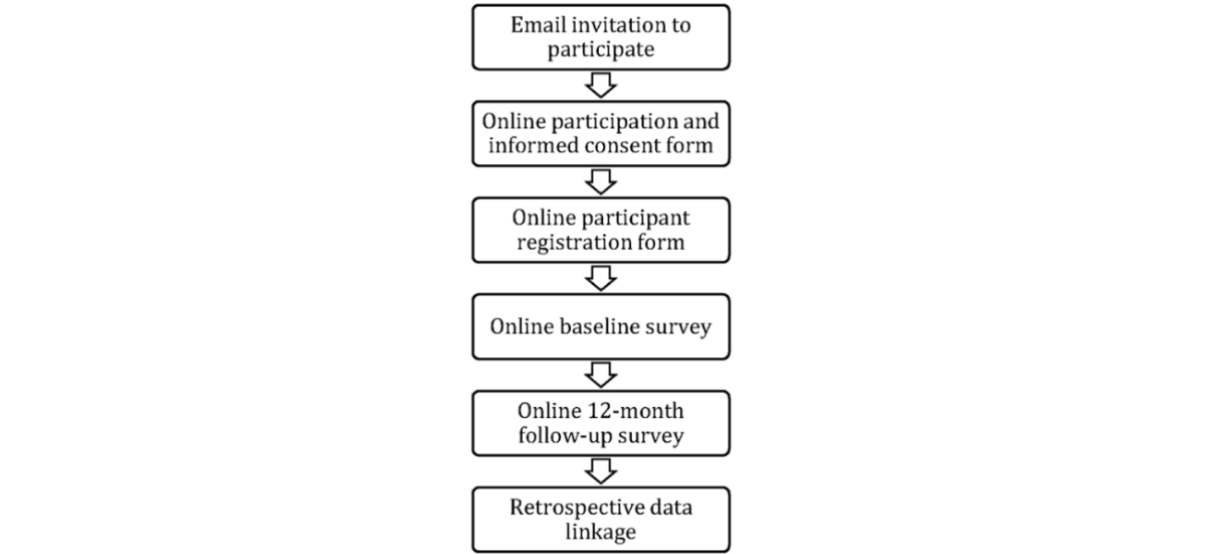
Figure 1. Flowchart of the study